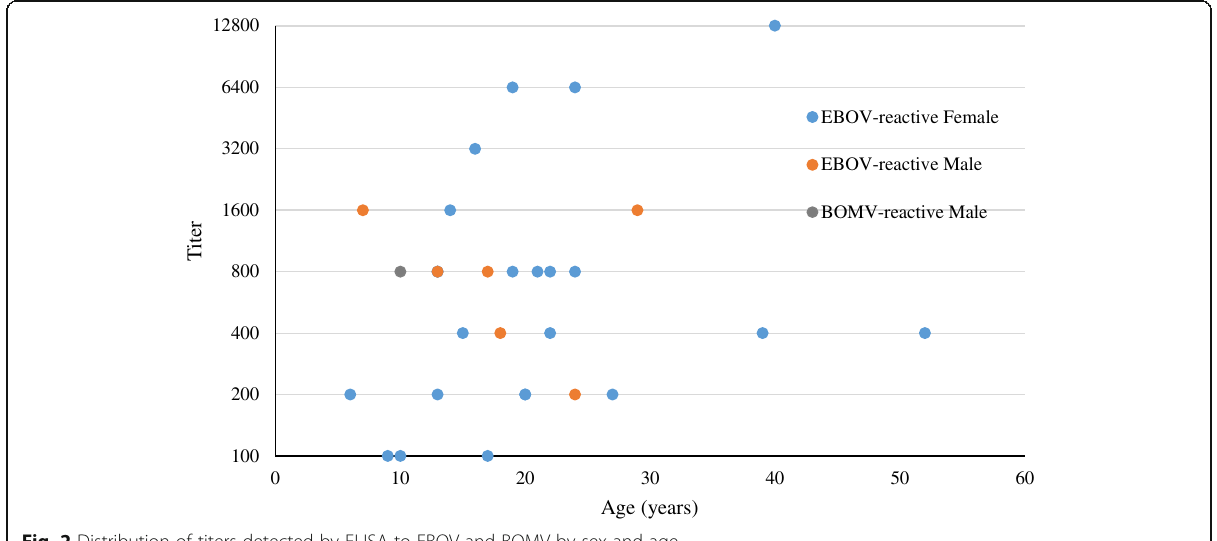
Fig. 2 Distribution of titers detected by ELISA to EBOV and BOMV by sex and